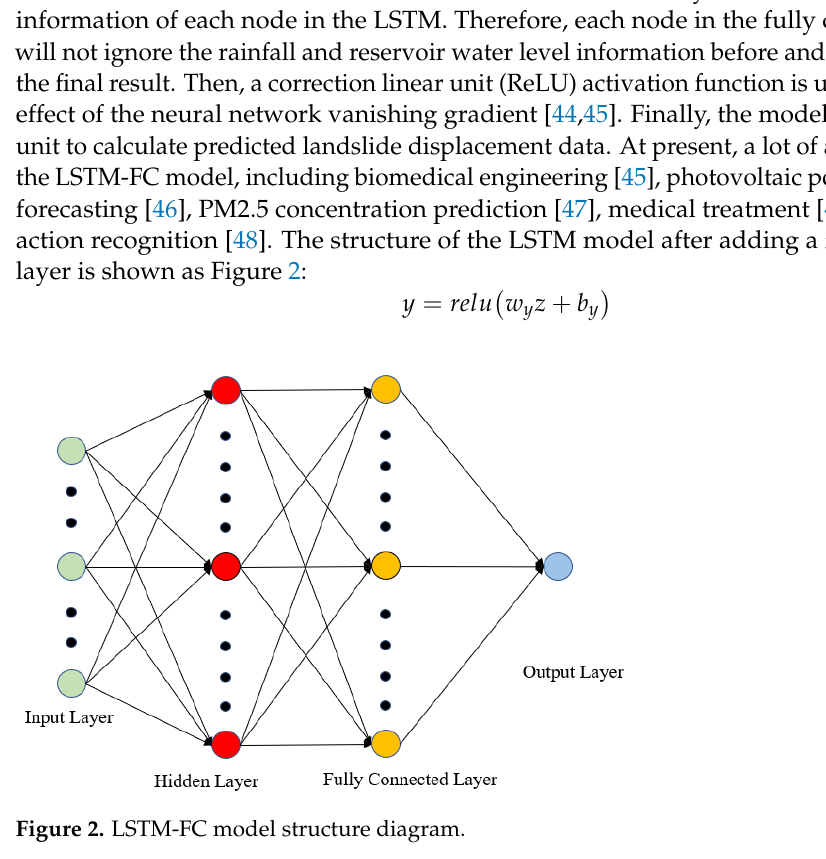
Figure 1. LSTM model structure diagram.